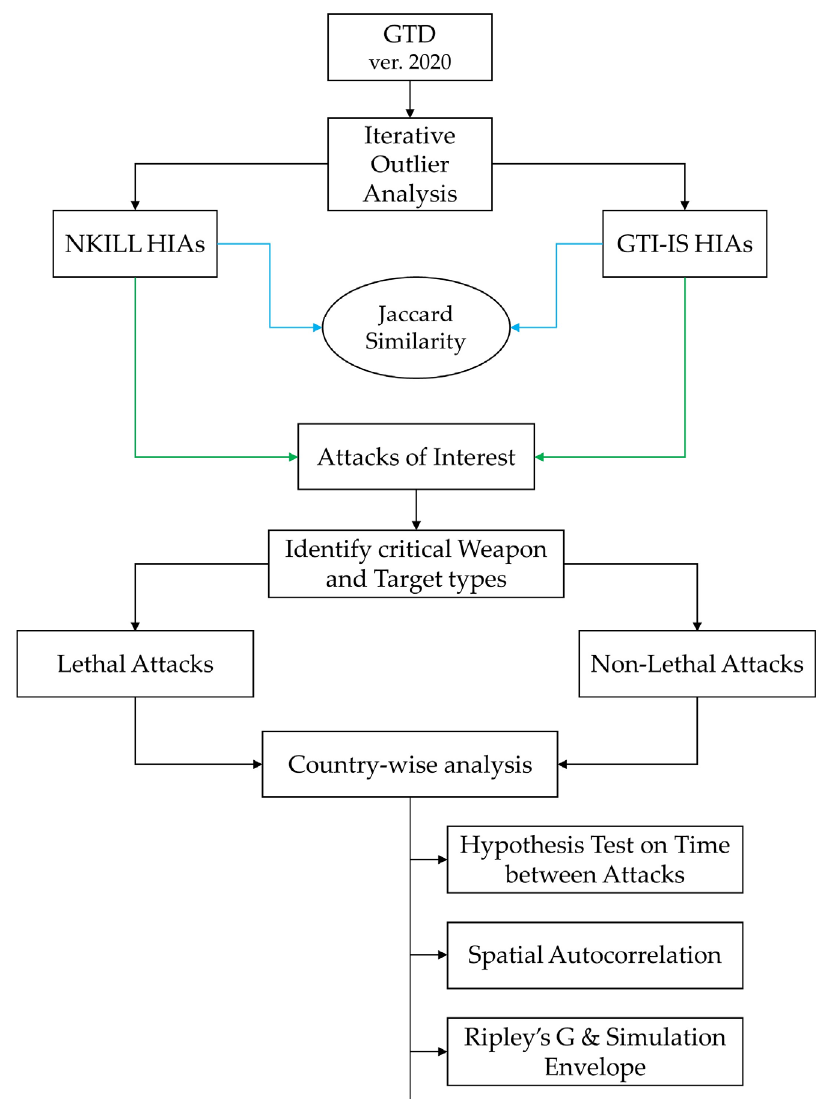
Figure 1. An overview of the complete analysis process of this research.